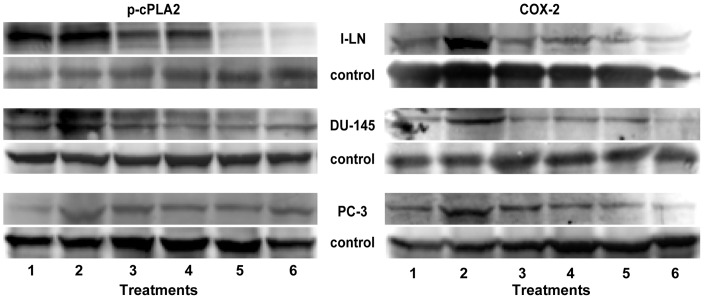
Suppression of elevated expression of the inflammation markers p-c-PLA2 and COX-2 in prostate cancer cells stimulated with 8-CPT-2Me-cAMP (100 μM/30 min by COX-2 inhibitors.A representative immunoblot of p-cPLA2 and COX-2 from three experiments along with their protein loading control is being shown. The lanes in p-cPLA2 and COX-2 immunoblots are: (1) buffer; (2) 8-CPT-2Me-cAMP (100 μM/30 min); (3) AH23848 (1 μM/3 h); (4) AH23848 then 8-CPT-2Me-cAMP (100 μM/30 min); (5) SC58125 (1 μM/3 h); (6) SC58125 then 8-CPT-2Me-cAMP (100 μM/30 min).